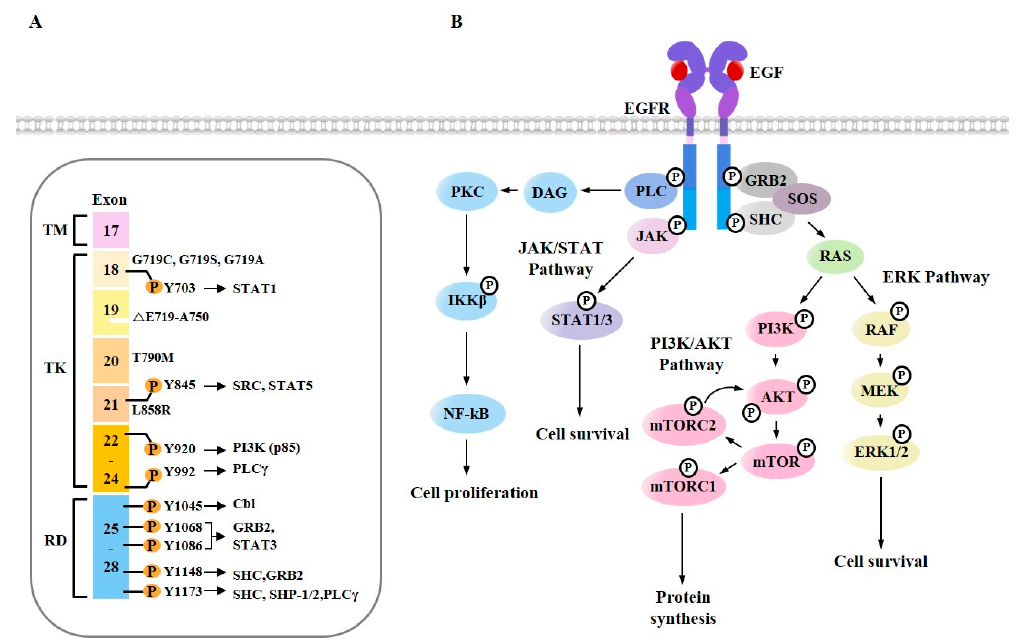
Figure 3. Ligand-dependent EGFR signaling pathways. ( A ) The proteins recruited on tyrosine-phosphorylated EGFR residues are shown. Numbers correspond to amino acids of EGFR. TM denotes transmembrane domain, TK denotes tyrosine kinase domain, and RD denotes regulatory domain. Specific mutations in the kinase domain and regulatory domain of EGFR are shown. ∆ denotes deletions. ( B ) EGFR activates RAS / MAPK and JAK / STAT signaling pathways for cell survival. Activation of PI3K / AKT / mTOR signaling pathway leads to protein synthesis. EGFR activates Phospholipase C gamma (PLC γ ), which in turn activates PKC / IKK β / NF- κ B signaling